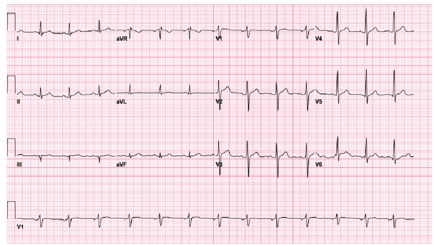
Figure 1: Initial electrocardiogram, showing evidence of acute inferior myocardial infarction.